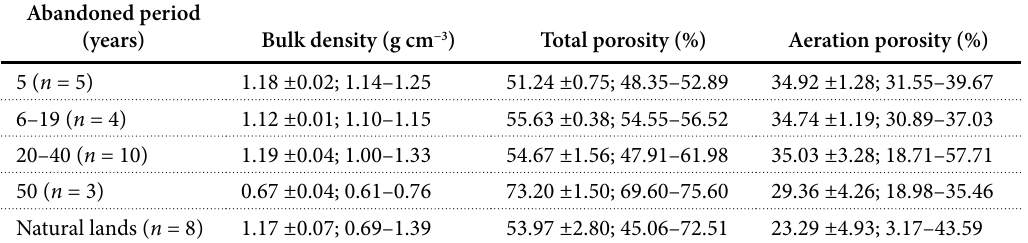
Tab. 2 Dynamics of changes in the physical properties of fallow floodplain soils on postagricultural succession. Abandoned period